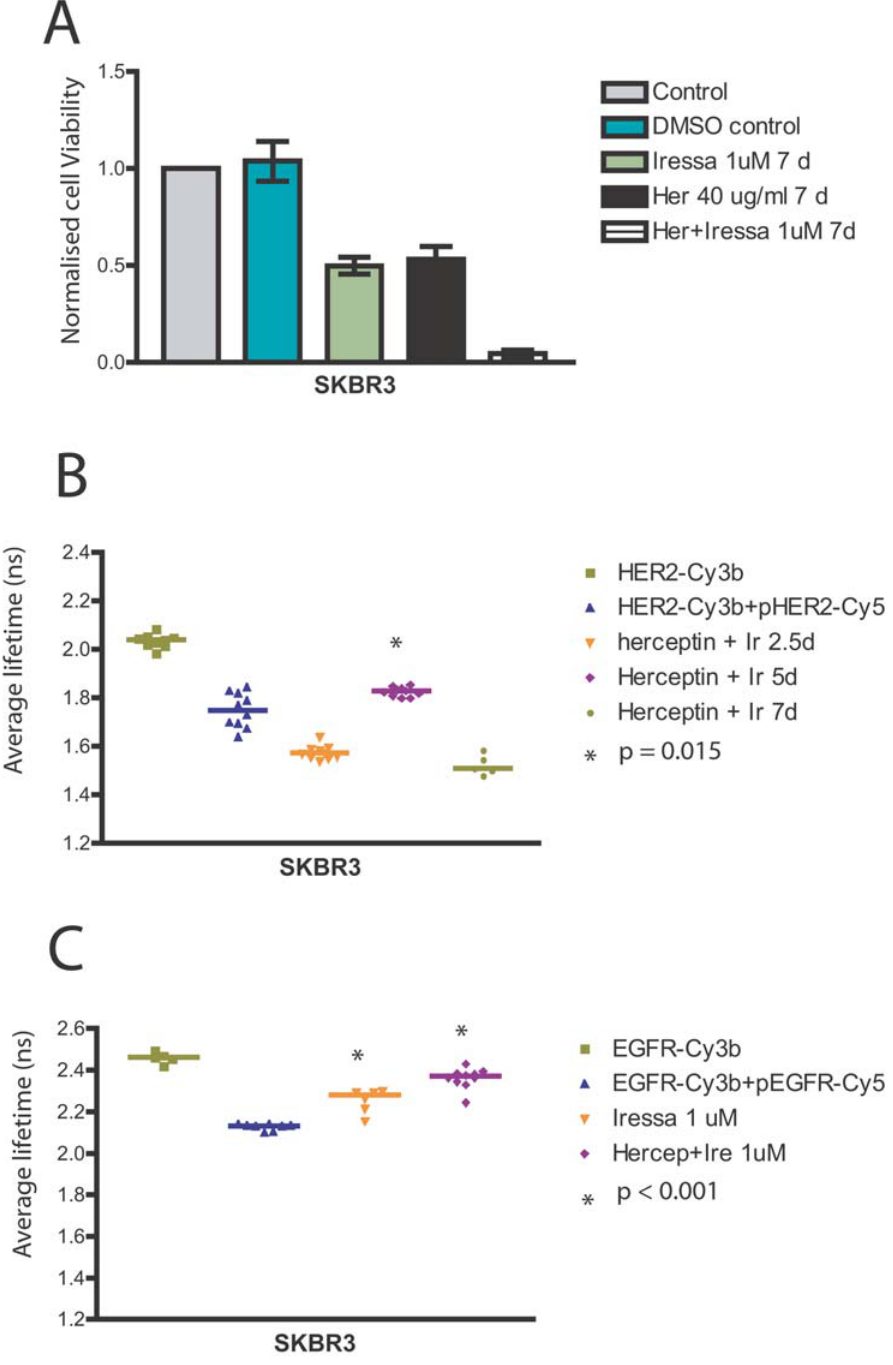
Figure 4. Combined therapy of Iressa and Herceptin was additive compared to either therapy alone due to greater inhibition of EGFR and HER2 phosphorylation. A, SKBR3 cells were grown in 24-well plates for at least 24 hours before treatment with 1 m M Iressa, 40 m g/ml Herceptin or 1 m M Iressa with 40 m g/ml Herceptin for 7 days. The viable cells were counted in a cell viability analyzer and normalised to the control. B, SKBR3 cells were treated with 40 m g/ml Herceptin and 1 m M Iressa for different durations and HER2 activation was monitored by FRET. A Mann- Whitney test was used to compare the medians of their lifetimes with the basal state (no drug treatment). C, SKBR3 cells were pre-treated with either 1 m M Iressa or combined treatment of 40 m g/ml Herceptin and 1 m M Iressa for 2.5 days before assessment of EGFR phosphorylation by FRET. The medians of the average lifetimes for the cells treated with drugs were compared with those without drug treatment using a Mann-Whitney test. doi:10.1371/journal.pone.0002881.g004 when these cells are treated with an oestrogen deprivation anti- loops are activated [35]. Iressa has been used to overcome hormonal treatment such as tamoxifen, it has been shown that hormone resistance in oestrogen deprived MCF-7 cells [35]. Thus, EGFR/HER2 heterodimer levels become elevated and autocrine the response to these drugs may depend more on the activation